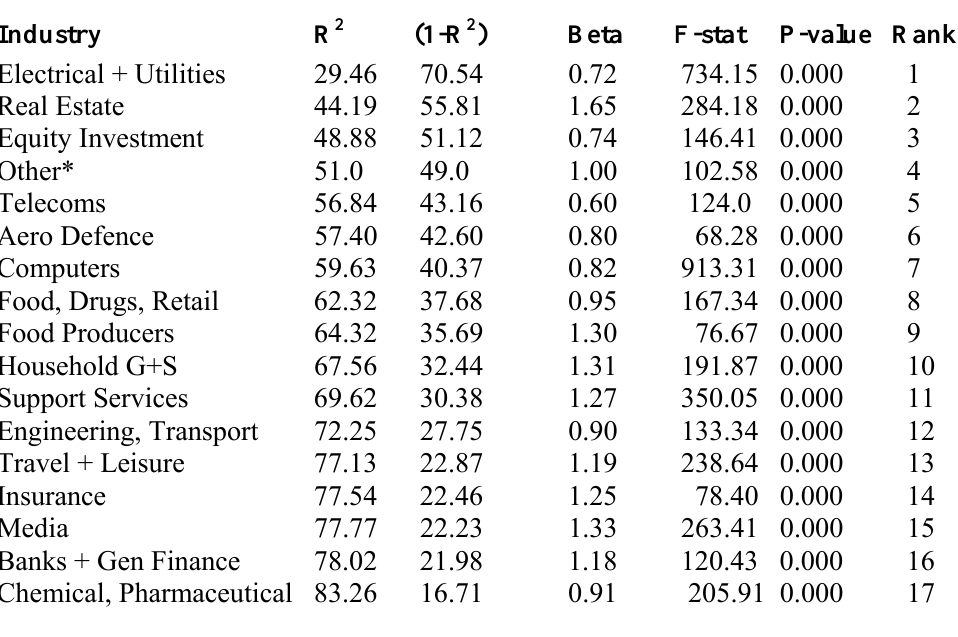
Table 4: (Maximum Proportion of) Stock Picking in the FTSE350 by Industry